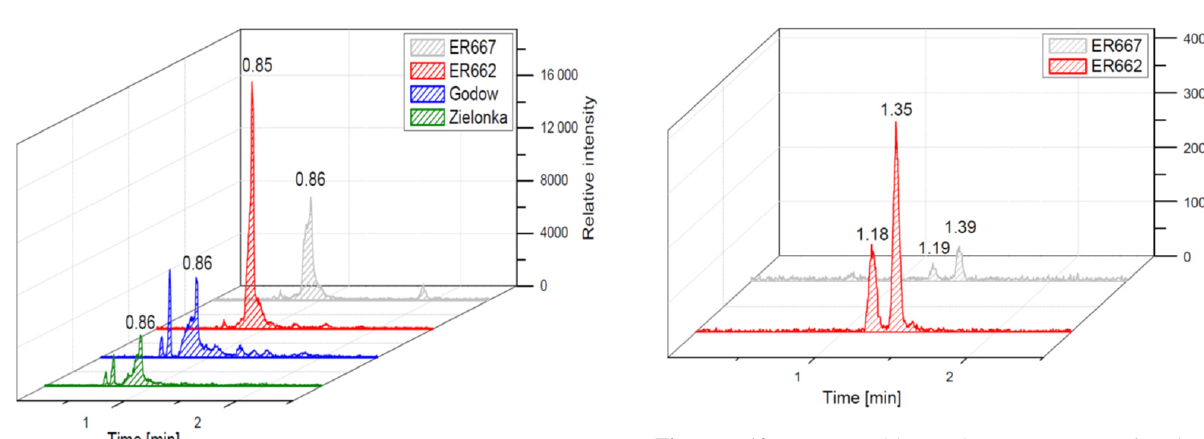
Figure 10. Extracted-ion chromatograms of nitrosoxy- organosulfate with MW 245 from chamber experiments (not detected in field